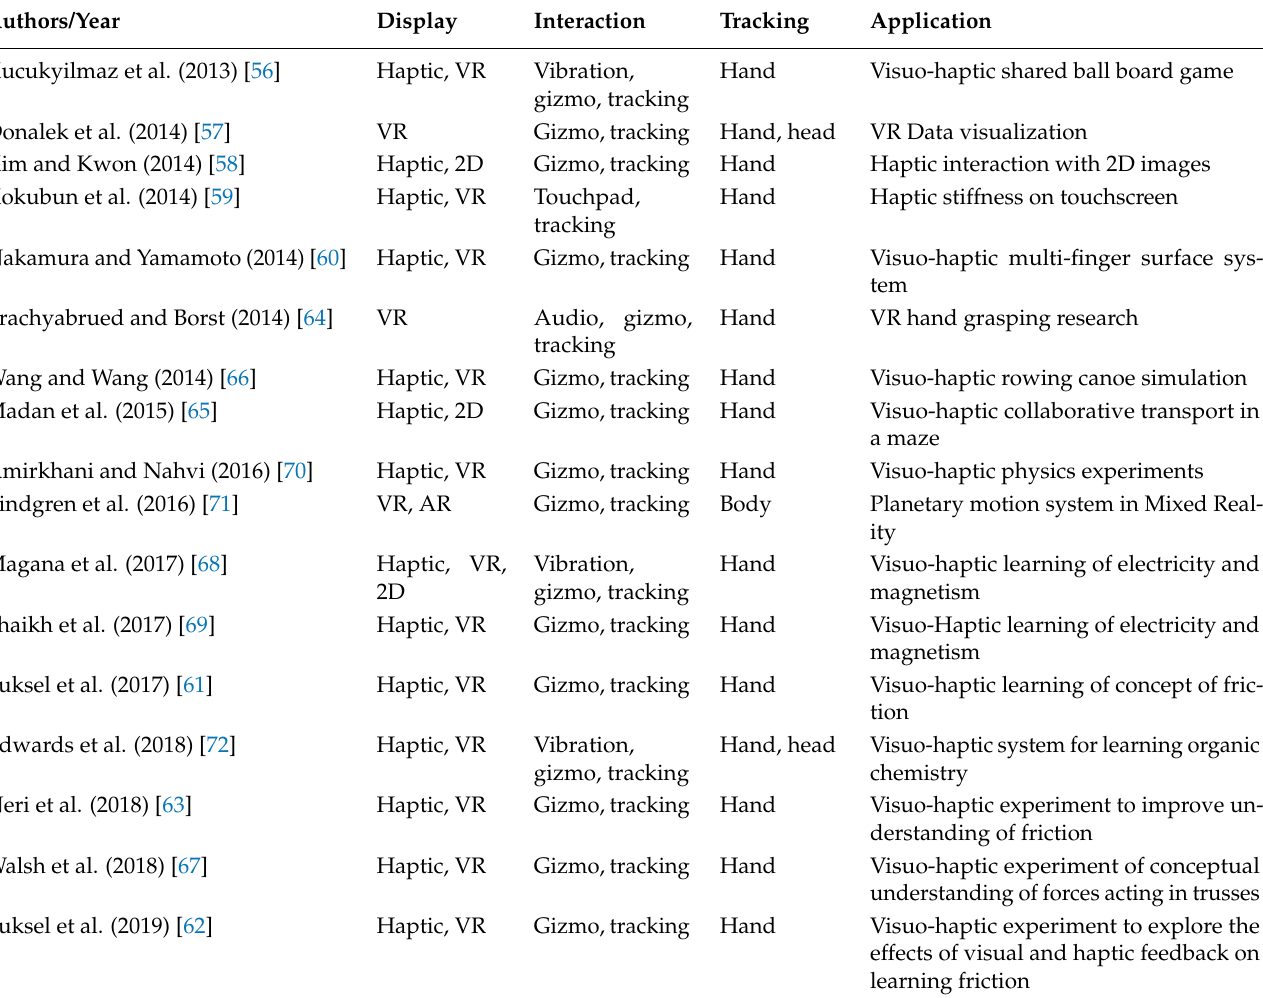
Table 4. Data table of the Physics